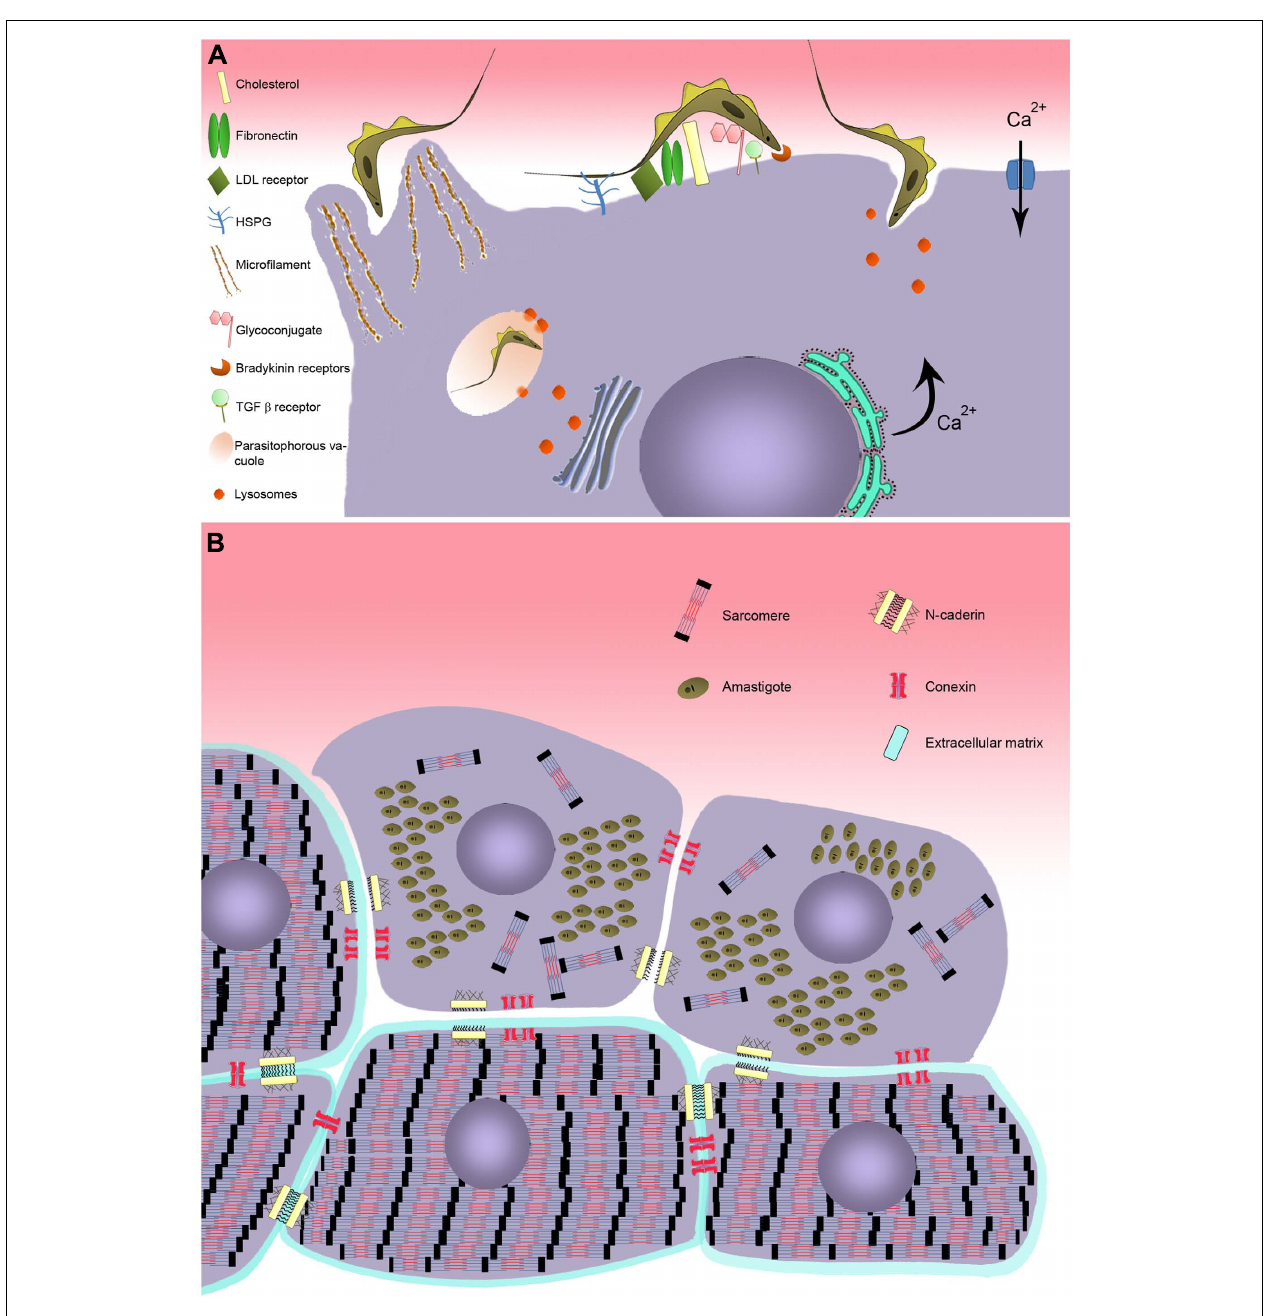
FIGURE 1 | Model of T. cruzi invasion in cardiomyocyte . (A) Schematic model representing the recognition step involving cell surface molecules of cardiomyocyte during T. cruzi invasion.Two distinct mechanism of invasion are represented: actin-dependent and lysosome-dependent